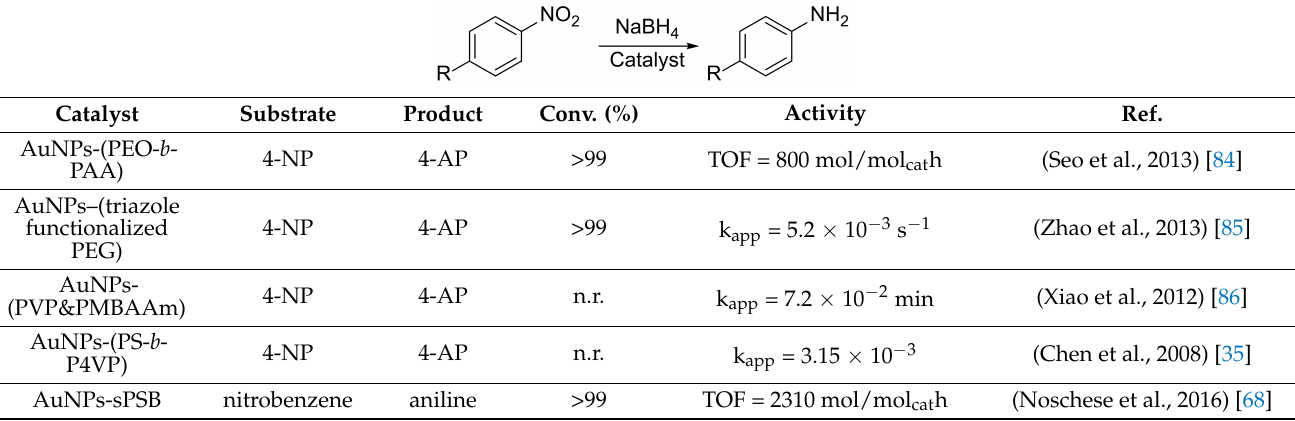
Table 2. Reduction of nitroarenes with NaBH 4 promoted by polymer supported